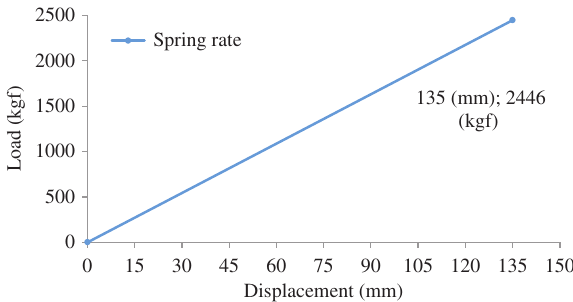
Figure 6: Desired load-deflection diagram for the leaf spring.